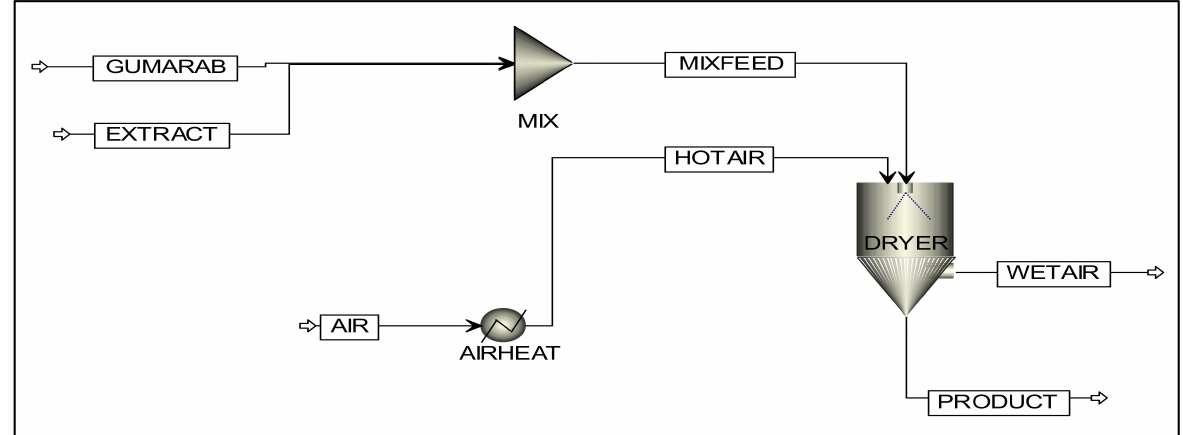
Figure 7. Aspen Plus Spray Drying process flow